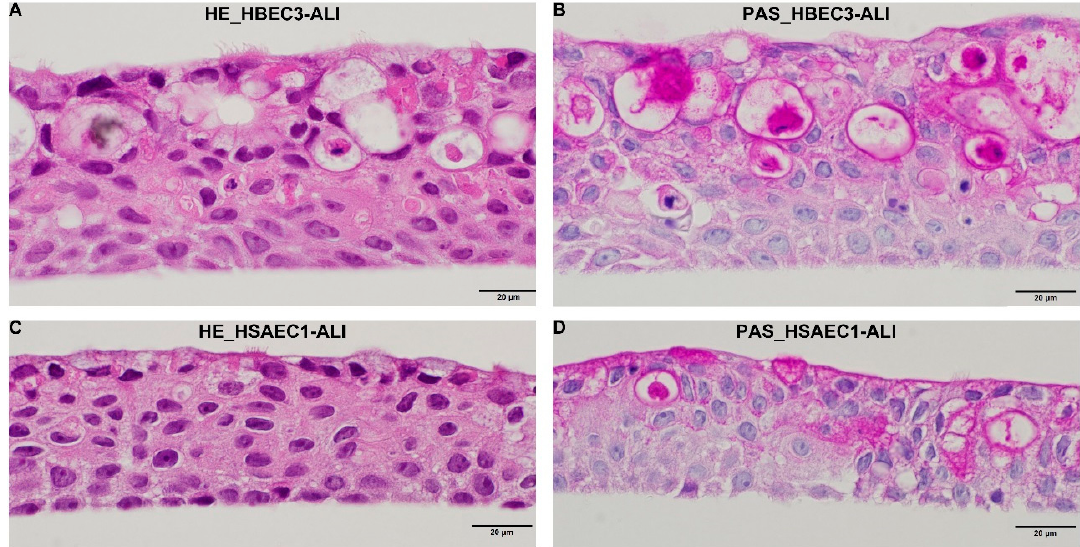
Figure 1. Histological morphology of HBEC3 and HSAEC1 cells cultured using the air–liquid–interface (ALI) system. Hematoxylin and eosin (HE) staining ( A and C ) and periodic acid-Schiff (PAS) staining ( B and D ) of HBEC3-ALI (A and B) and HSAEC1-ALI (C and D) cultures.